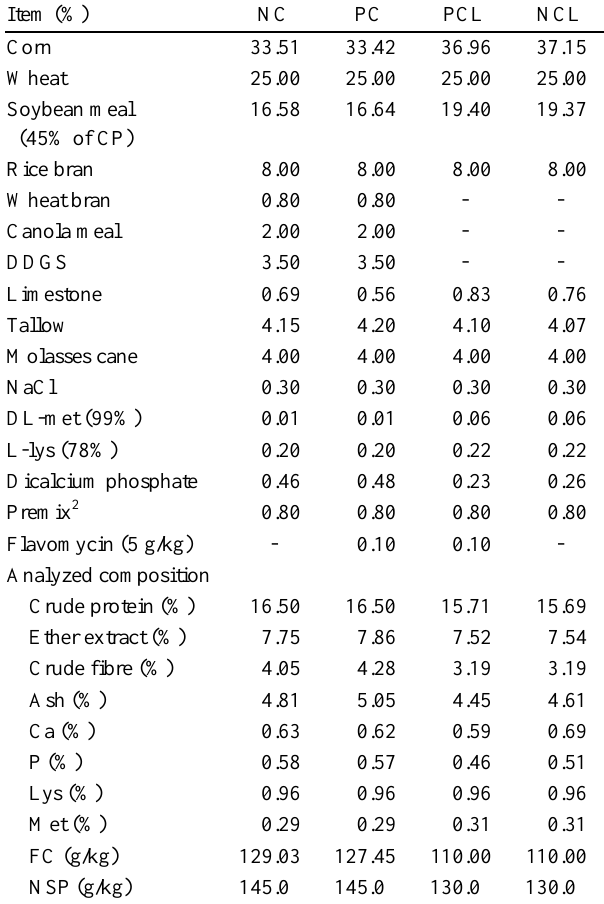
Table 1. Compositions of basal finishing pig diets (as-fed basis)